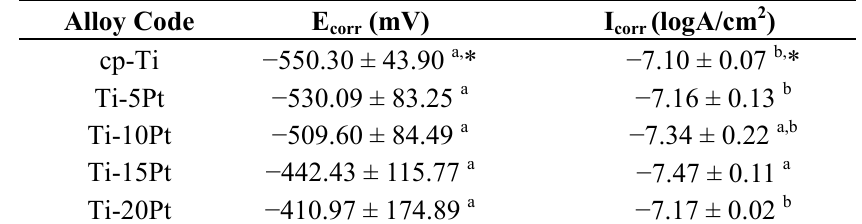
Table 2. Corrosion potential (E alloys (number of measurements = 3).